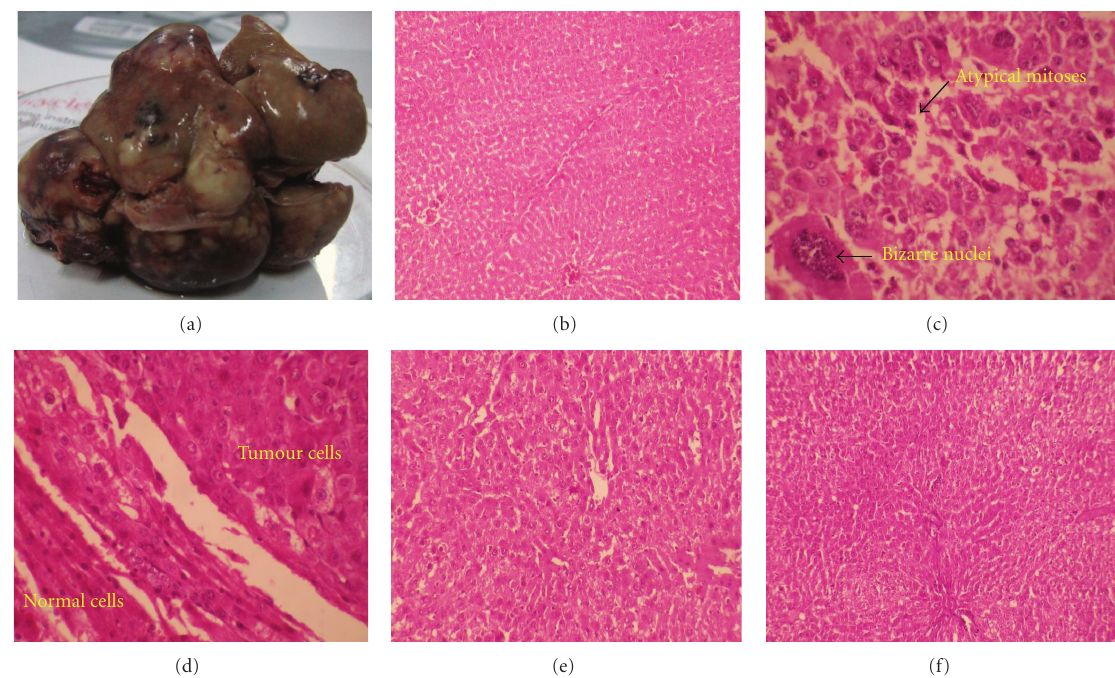
Figure 4: E ff ect of TD on gross morphology and histopathology in liver of control and experimental animals. (a) Gross morphology of Group II animals (AFB 1 induced). (b) Liver tissue of Group I control animals (10X). (c) Liver tissue of Group II (AFB 1 induced) animals (40X). (d) Liver tissue of Group II (AFB 1 induced) animals (40X). (e) Liver tissue of Group III (AFB 1 induced + TD treated) animals (10X). (f) Liver tissue of Group IV (TD treated) animals